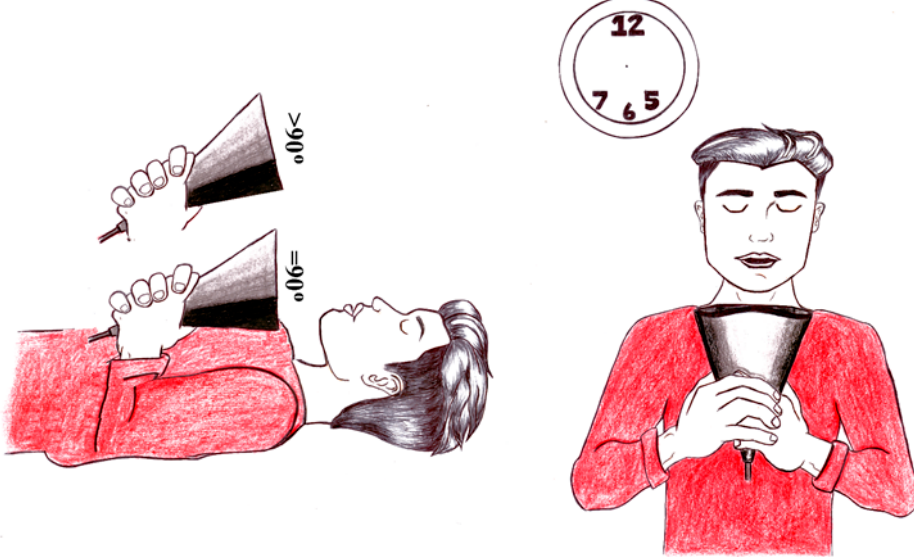
Figure 3. Positioning possibilities of the Dental Aerosol Suction Device.